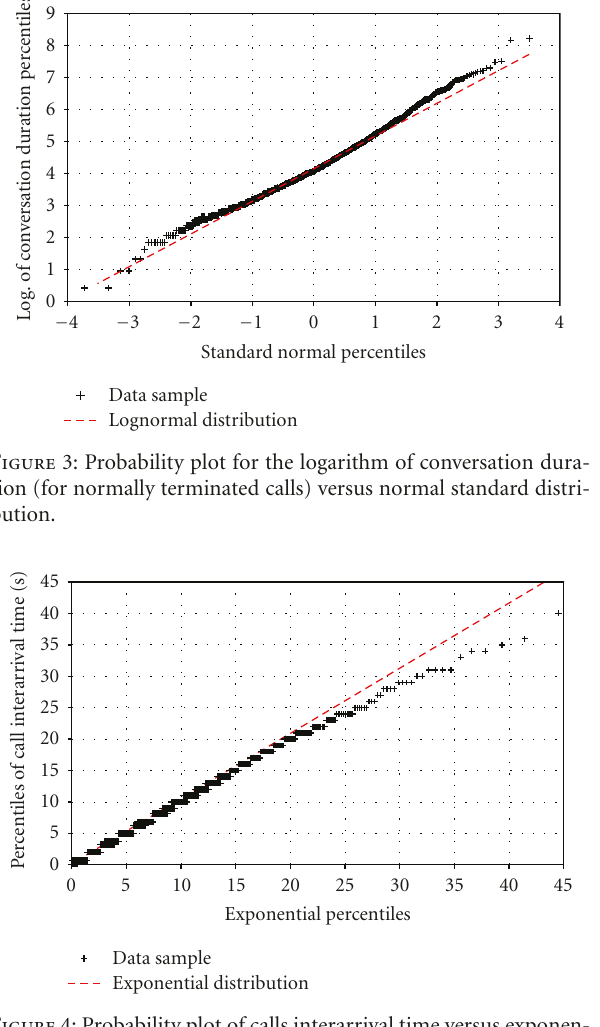
Figure 4: Probability plot of calls interarrival time versus exponen- tial